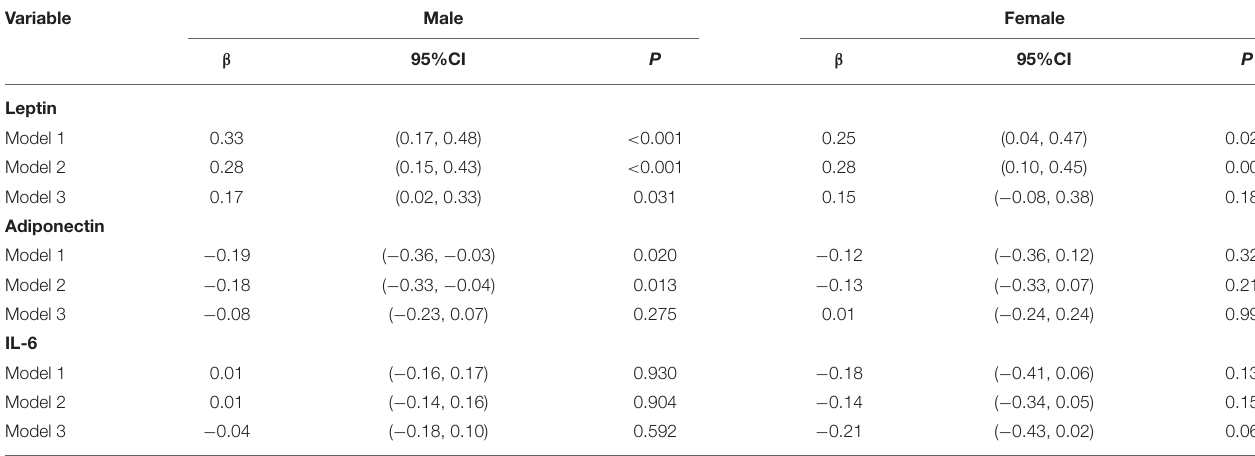
TABLE 4 | Multiple linear regressions of serum adipokines and REE for males and females.